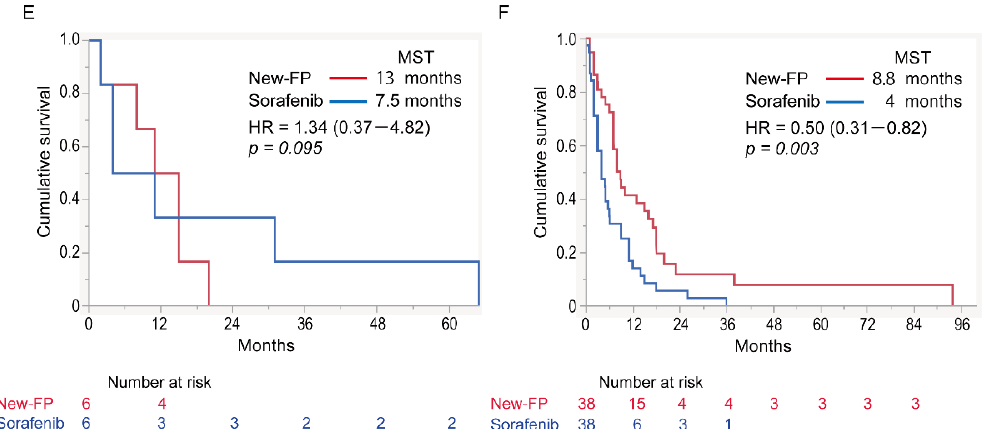
Figure 2. Overall survival curves for patients in the New-FP and sorafenib groups. ( A ) New-FP ( n = 418, red line) and sorafenib ( n = 844, blue line), before propensity score matching. ( B ) New-FP ( n = 198, red line) and sorafenib ( n = 198, blue line), after propensity score matching. ( C ) Cohort 1 (no MVI or EHS), New-FP ( n = 38, red line) and sorafenib ( n = 38, blue line). ( D ) Cohort 2 (MVI with no EHS), New-FP ( n = 78, red line), and sorafenib ( n = 78, blue line). ( E ) Cohort 3 (EHS with no MVI), New-FP ( n = 6, red line), and sorafenib ( n = 6, blue line). ( F ) Cohort 4 (MVI and EHS), New-FP ( n = 78, red line), and sorafenib ( n = 78, blue line). HR, hazard ratio; MST, median survival time; New-FP, fine-powder cisplatin and 5-fluorouracil; EHS, extrahepatic spread; MVI, macrovascular inva- sion.